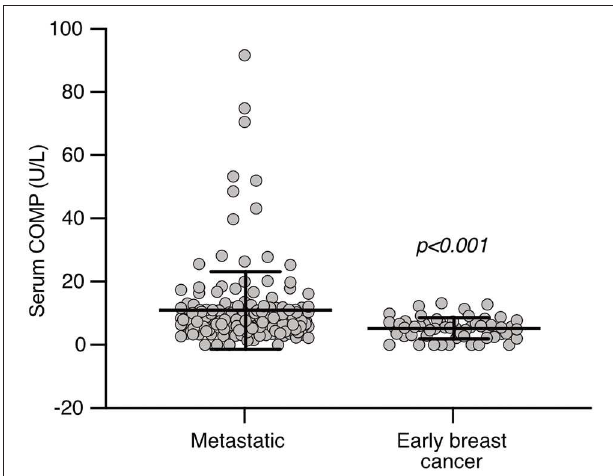
FIGURE 2 | COMP levels in patient sera. COMP levels were measured in sera using IVD approved ELISA and significantly higher levels were detected in sera of patients with metastatic breast cancer compared to early breast cancer. Mann-Whitney two-tailed p -value.